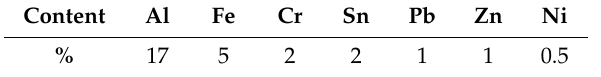
Table 9. Deportment of various elements between the Cu-rich, Al-rich, and other phases in samples M Table 8. Averaged content of various elements in samples M and S measured by MLA. and